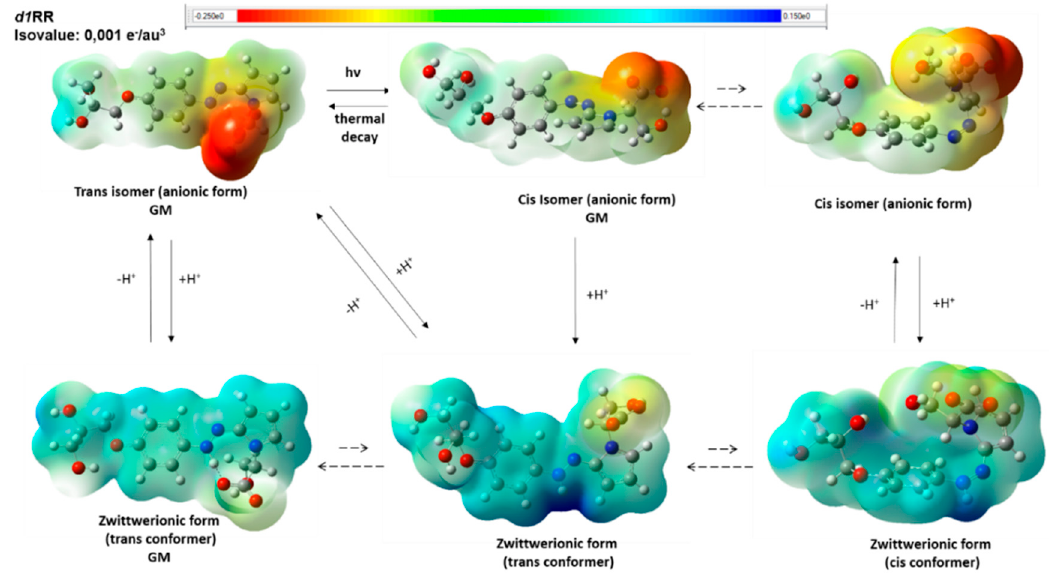
Figure 7. Putative d 1RR ionic species present in solution in the pH range considered during the fast UV experiments according to DFT calculations. Dashed arrows indicate conformational equilibria between the di ff erent conformers and GM indicate the structure of the global minimum conformer. Structures are relative to the obtained DFT minima and are displayed as a ball and sticks. Heteroatoms are coloured by atom type: O, red; N, blue. The molecular electrostatic potential surface is displayed.